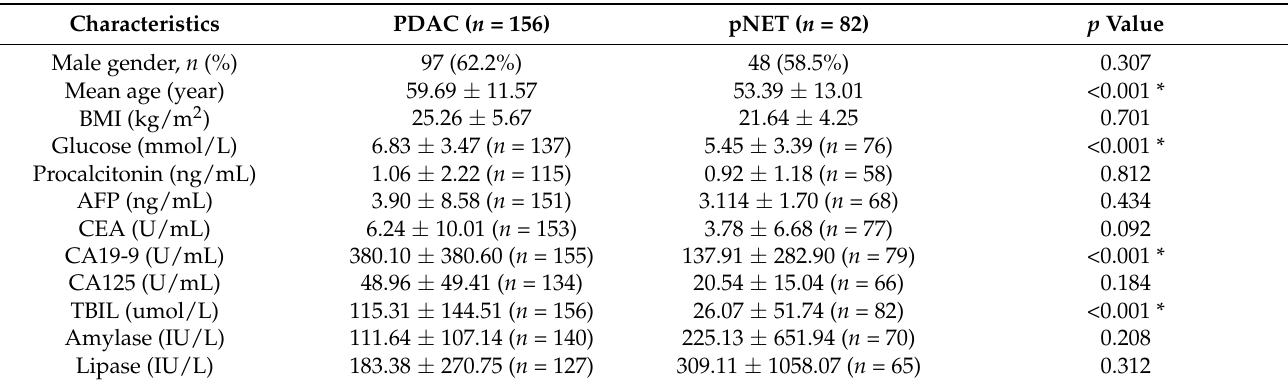
Table 1. Characteristics of